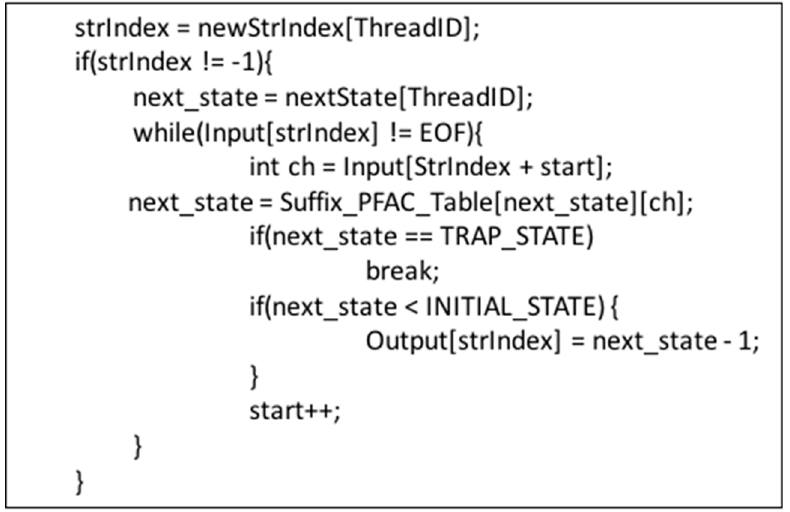
Figure 8. Phase two of the two-phase PFAC algorithm: Remainder traversal. Table 4. The information about the job mapping in the first phase.